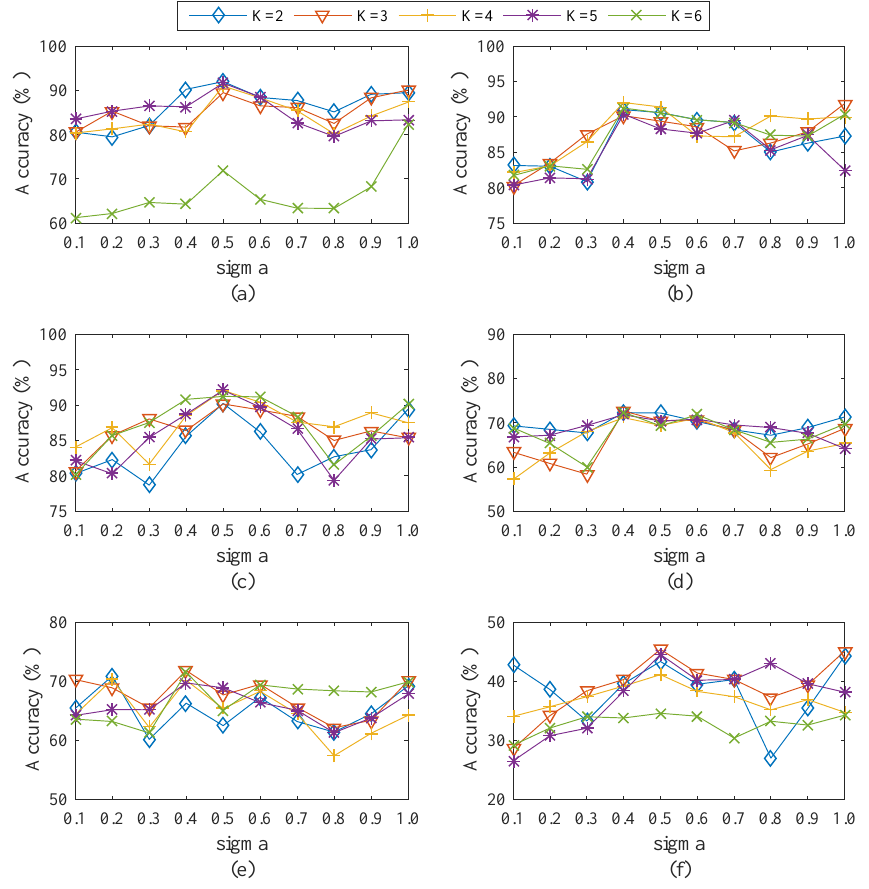
Figure 3. ( a–f ) Comparing SCDNN accuracy over several cluster numbers k and σ values for the six